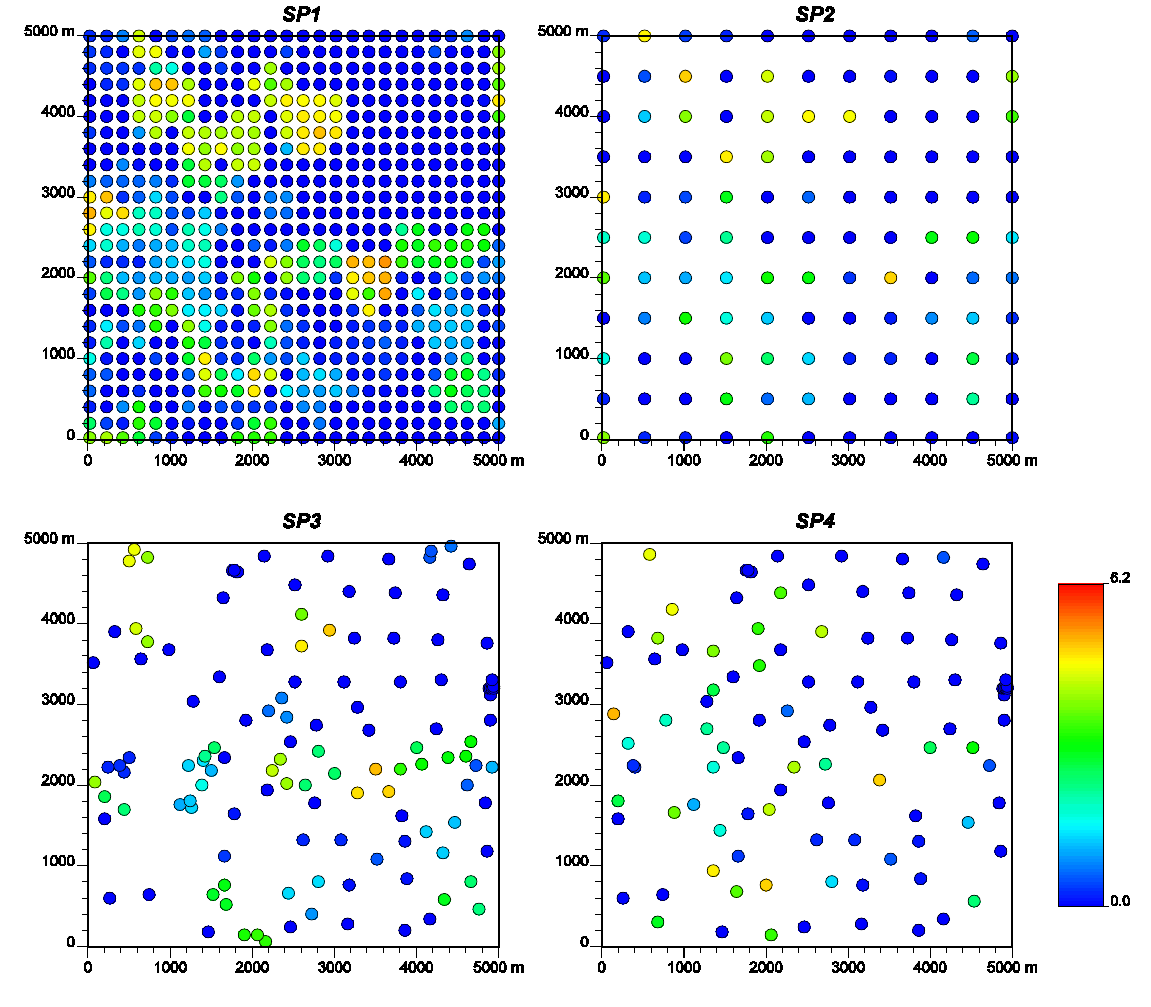
Figure 9. Systematic (top) and stratified (bottom) sampling schemes designed from the LAI reference